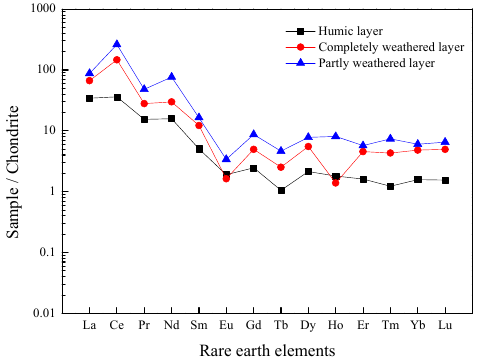
Figure 7. Chondrite standard of Fe–Mn state rare earth.